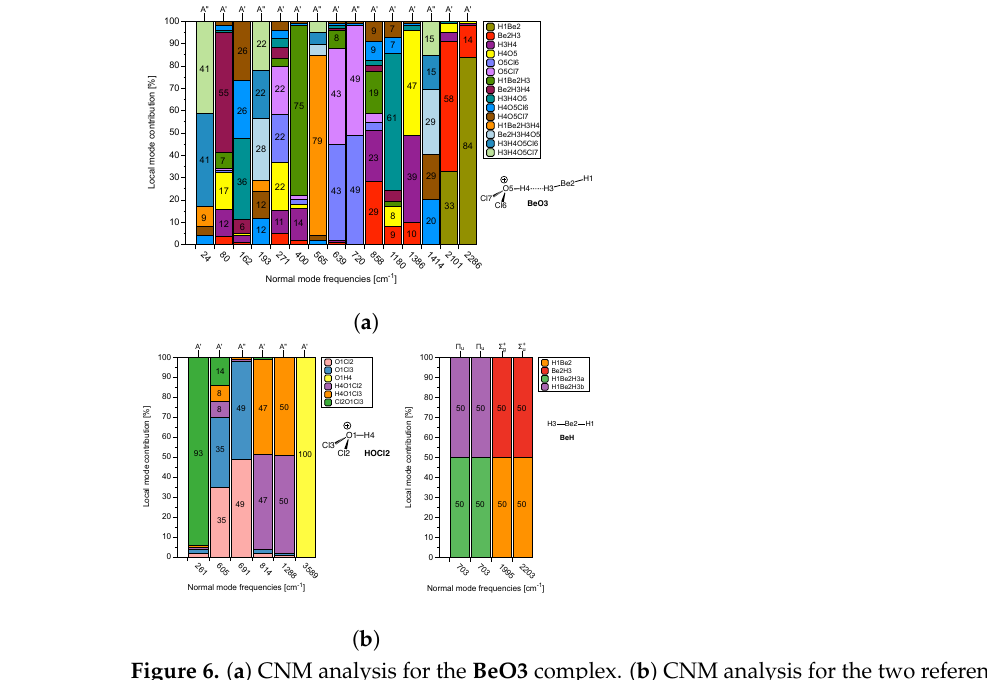
Figure 6. ( a ) CNM analysis for the BeO3 complex. ( b ) CNM analysis for the two reference molecules HOCL2 (DHB donor) and BeH (DHB acceptor) forming the complex. R 2 = 0.6666